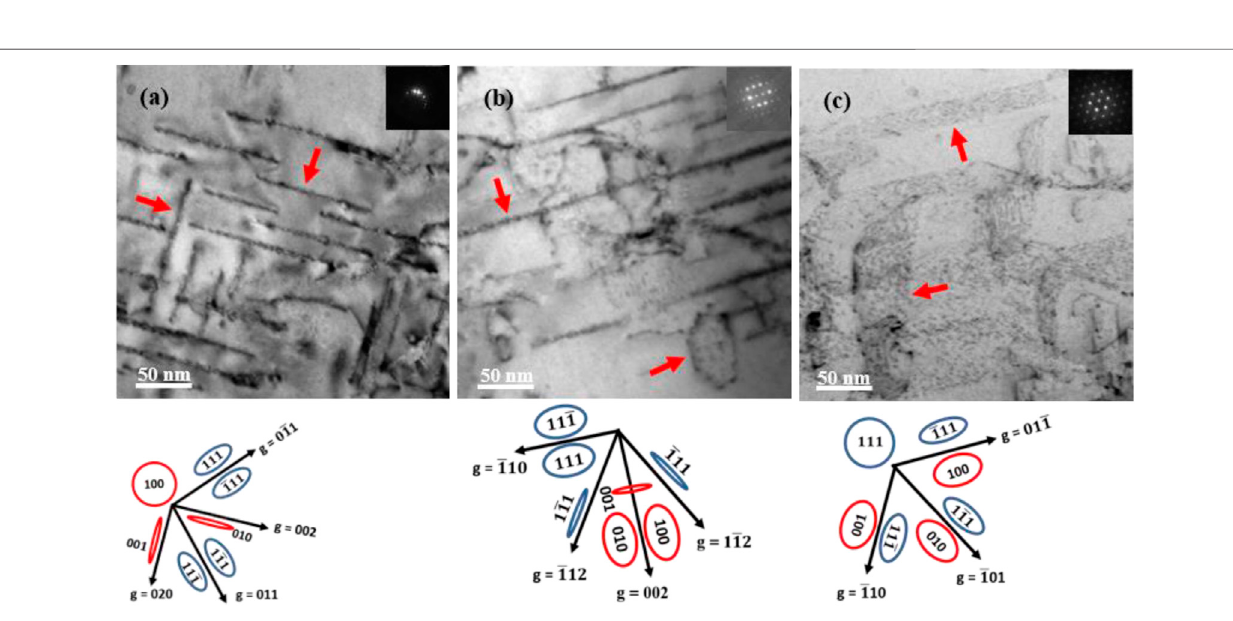
Frontiers in Energy Research |